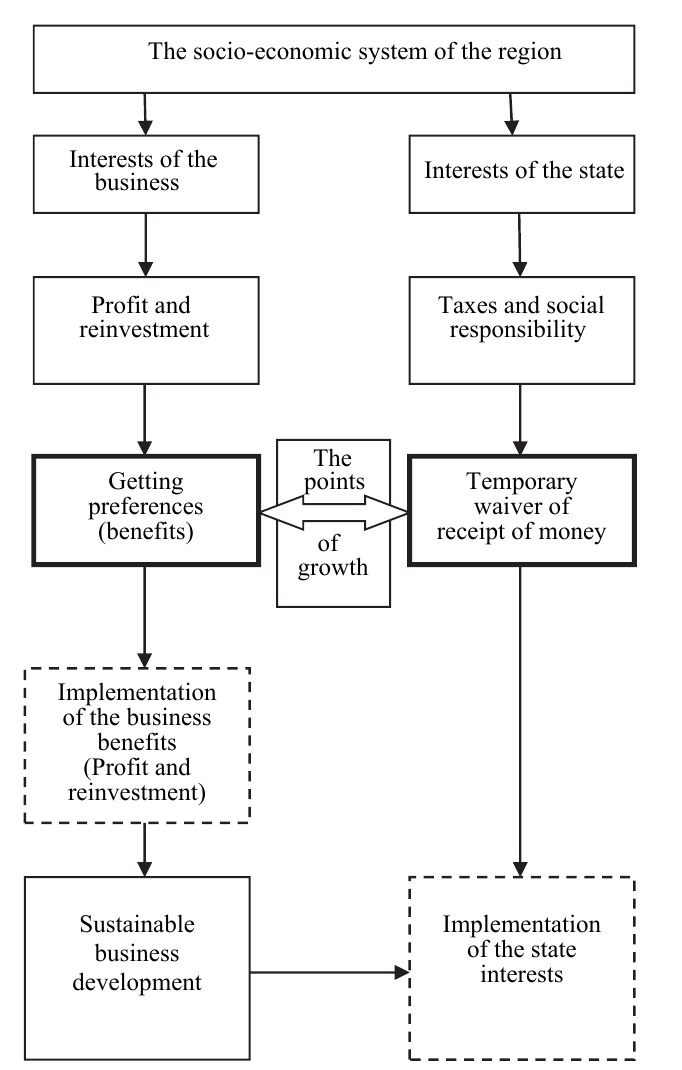
Fig. 2. The mechanism of producing a double effect on the implementation of public-private